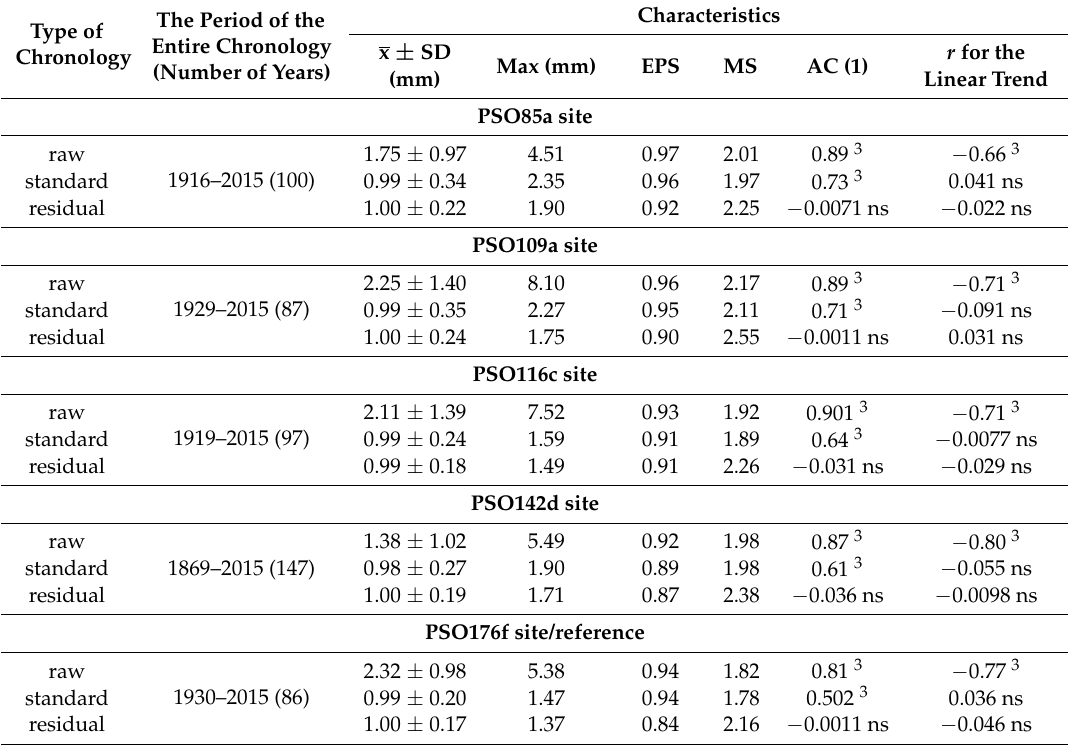
Table 4. Statistical characteristics determined for the site chronologies of Scots pine (PSO).